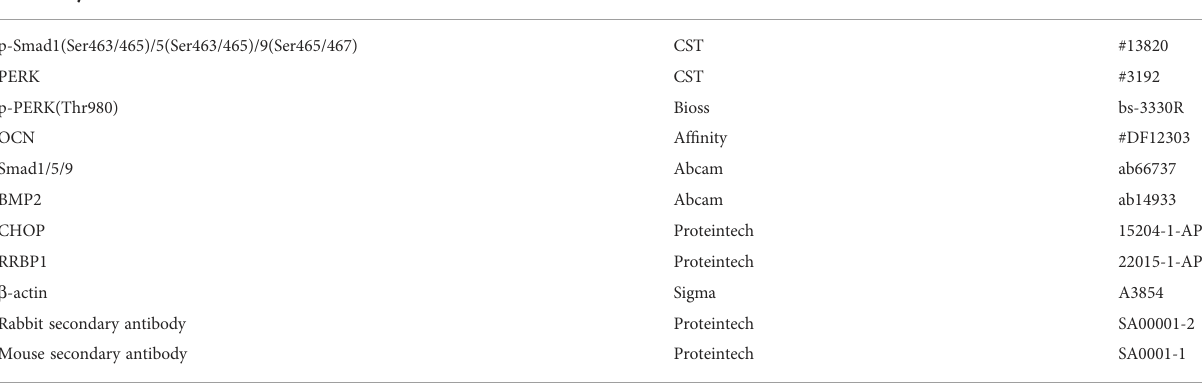
TABLE 3 Information of antibodies.